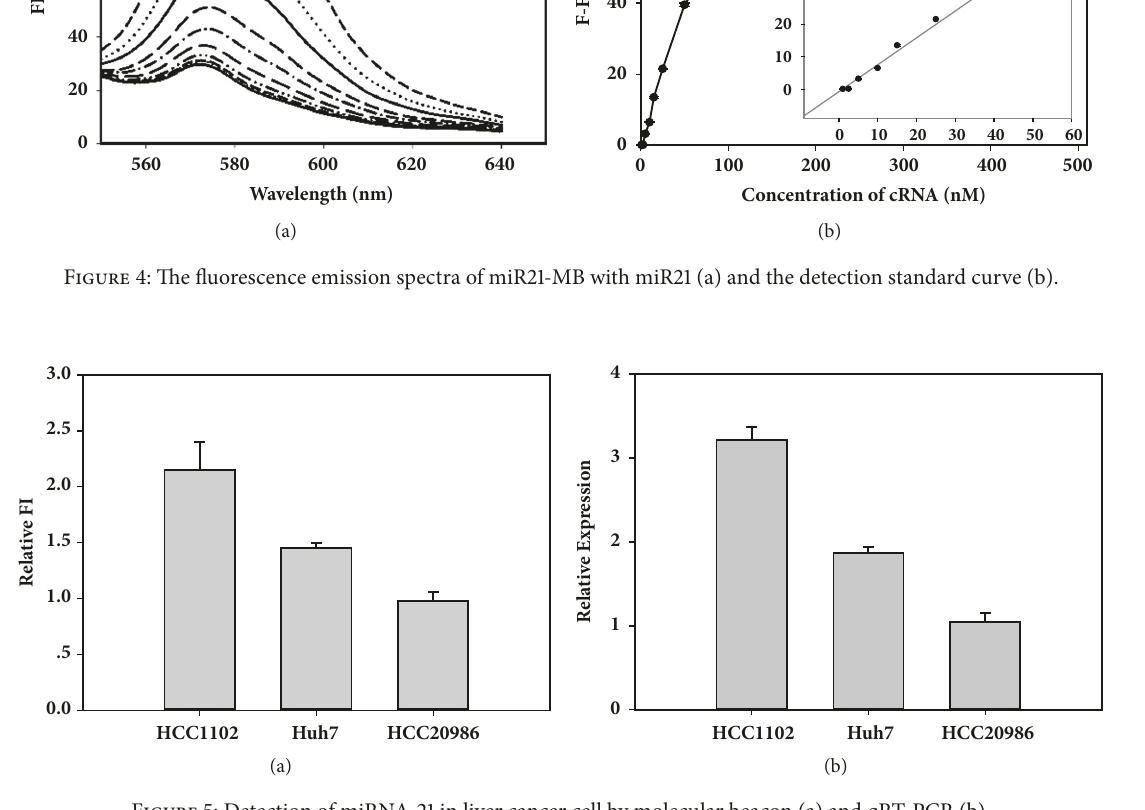
Figure 5: Detection of miRNA-21 in liver cancer cell by molecular beacon (a) and qRT-PCR (b).